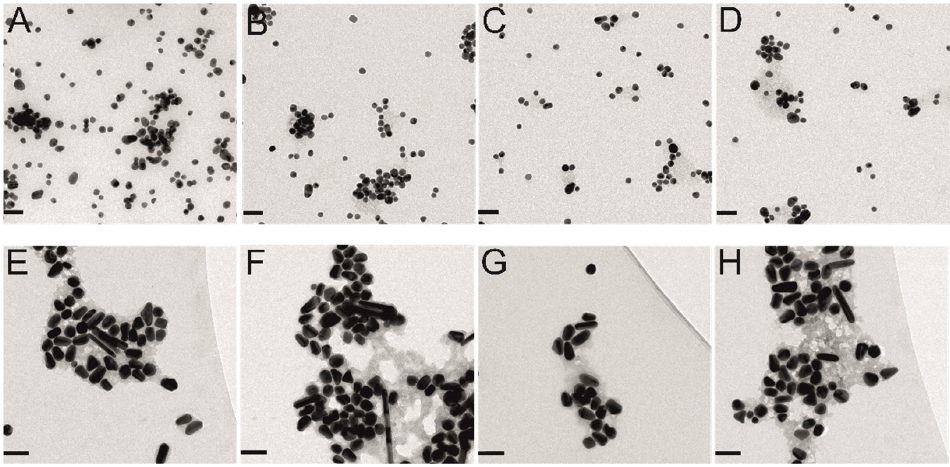
Figure 1. Transmission electron micrographs of the nanoparticles used in this study. ( A – D ) Citrate stabilized gold nanoparticles, scale bars: 50 nm. ( E – H ) Citrate stabilized silver nanoparticles, scale bars: 200